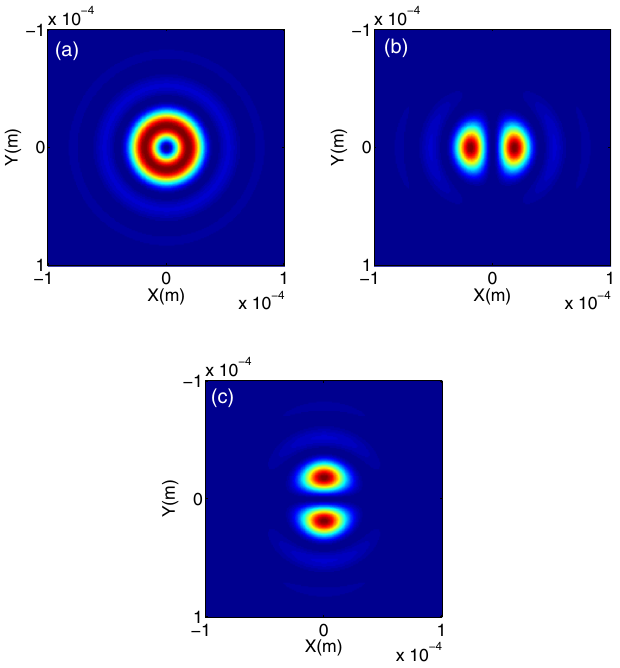
FIG. 5. Calculated OTR PSF images with (a) total, (b) horizontal polarization, and (c) the vertical polarization of the case: energy ¼ 14 : 3 MeV , M ¼ 1 , (cid:6) ¼ 500 nm , and ¼ 0 : 010 . (cid:4) max